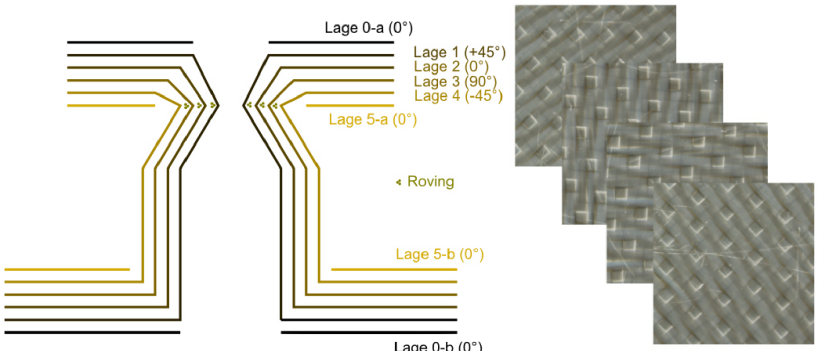
Figure 7. Layer structure of the laminate for prototype production with fabric images to illustrate the fibre